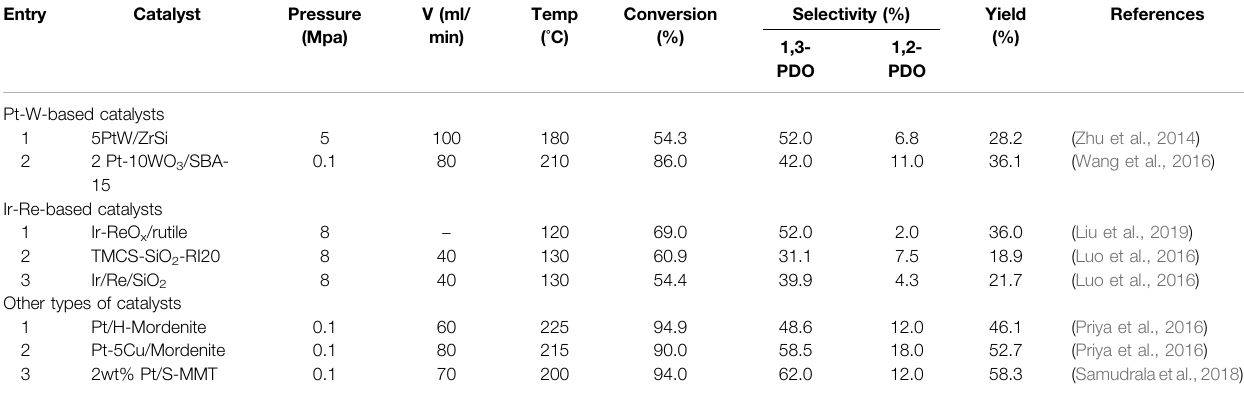
TABLE 2 | Comparison of catalytic performances of glycerol hydrogenolysis in fi xed-bed